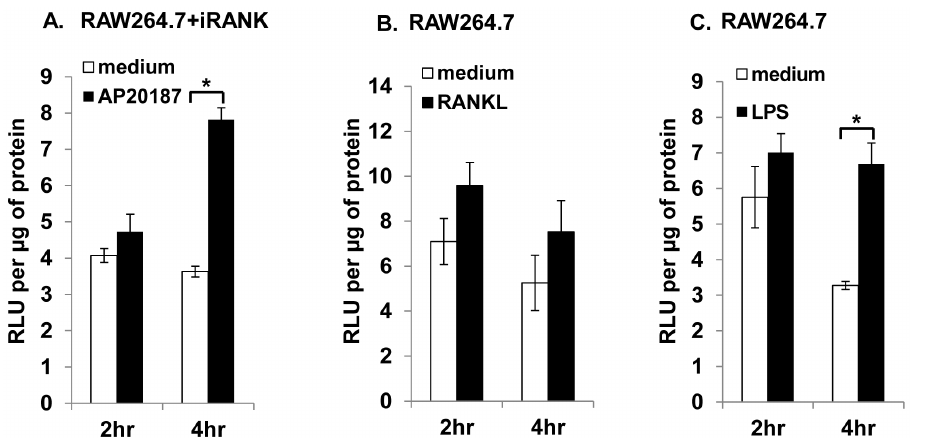
Figure 5. NF- k B signaling. NF- k B dependent signaling in engineered osteoclasts. RAW264.7 and RAW264.7 + iRANK cells were transiently transfected with a luciferase reporter construct containing NF- k B sites derived from Ig k promoter driving the luciferase gene and a Renilla luciferase construct as the internal control. NF- k B activation was measured in RAW264.7 + iRANK cells stimulated with AP20187 (A), and RAW264.7 cells stimulated with RANKL (B) or LPS (C) for 2 and 4 h. Data are average relative light units (RLU) per m g protein + / 2 SD. *p , 0.05.